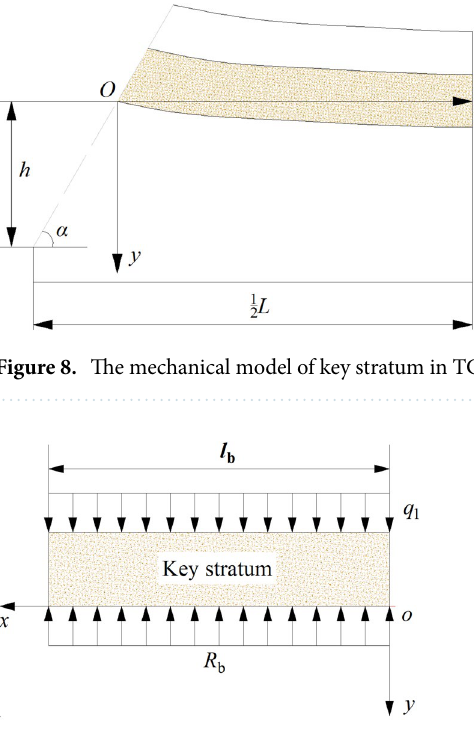
Figure 9. The mechanical model of key stratum in